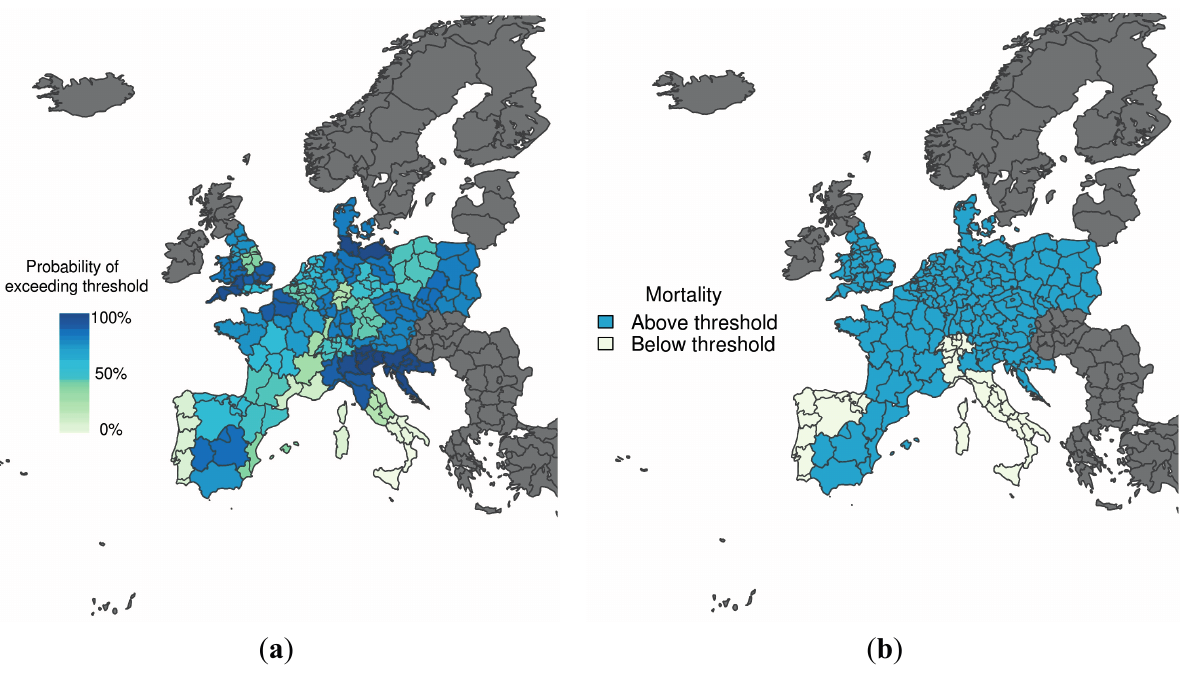
Figure 3. ( a ) Probabilistic map of exceeding emergency daily mortality thresholds (75th percentile of daily mortality distribution in the cold tail); ( b ) Corresponding observations during a cold wave scenario (1–15 January 2003). The graduated colour bar represents the probability of exceeding the mortality threshold (ranging from 0%, pale colours, to 100%, deep